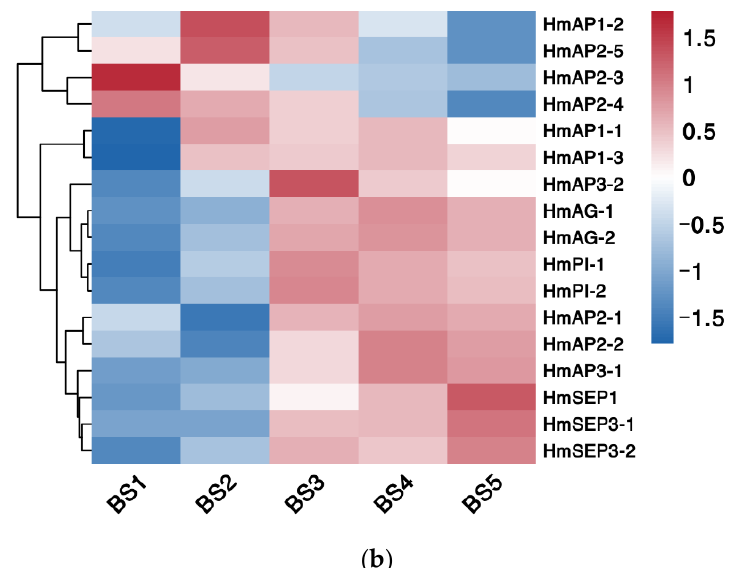
Figure 8. Phylogenetic and expression pattern analysis of genes associated with the ABCDE model. ( a ) Phylogenetic tree. ( b ) Cluster heatmap of DEGS related to the ABCDE model. The data preprocessing method takes the logarithm of the sequencing data with 2 as the base. A small square represents a gene, and its color represents the expression level of that gene. Red indicates high-expression genes, and blue indicates low-expression genes. The tree on the left side shows the results of clustering analysis of different genes from different samples.